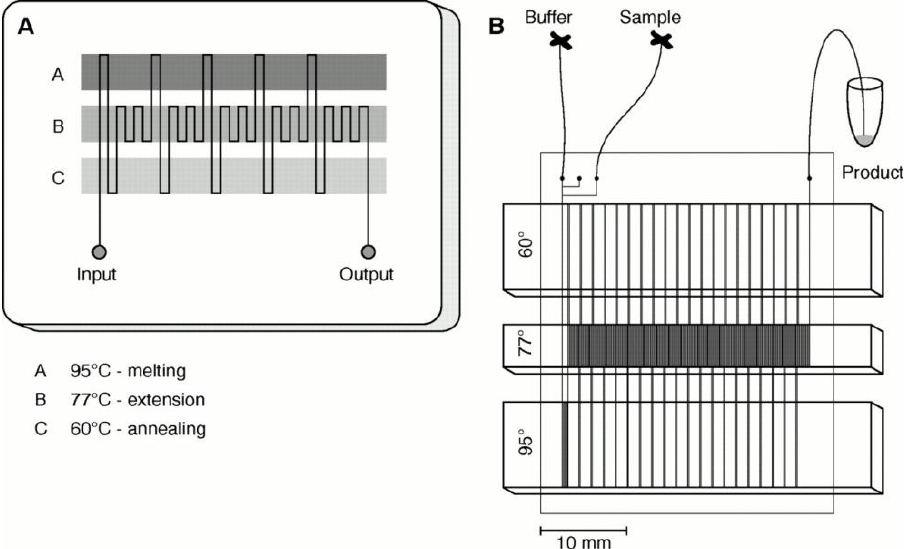
Figure 11. Continuous-flow PCR on a chip. Reprinted from [80] with permission © American Association for the Advancement of